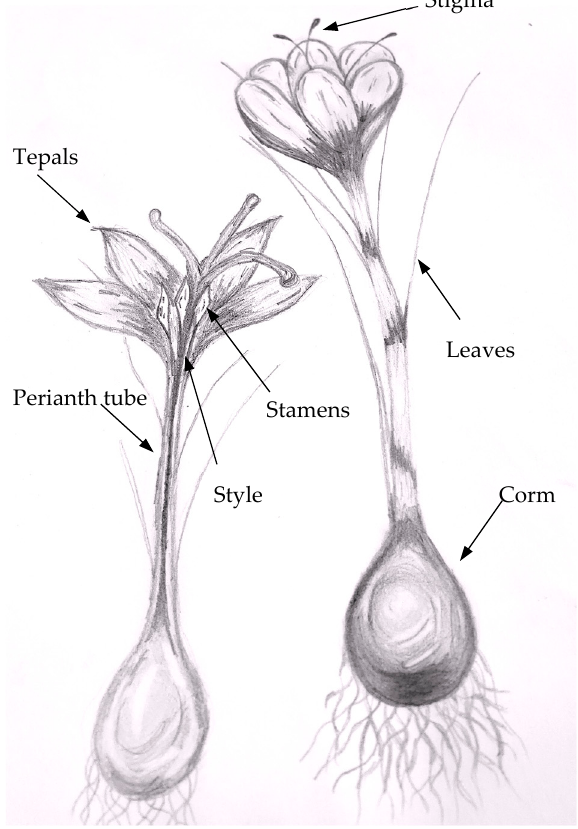
Figure 1. Crocus sativus L. plant parts.